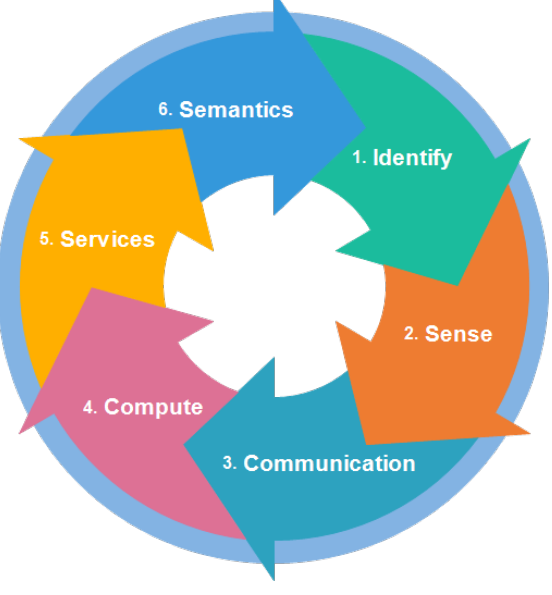
Figure 3. The IoT